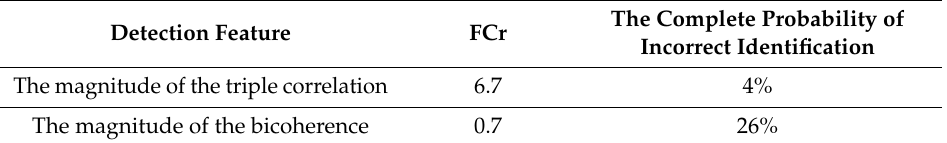
Table 2. Identification effectiveness of the proposed detection features and the bicoherence detection features.